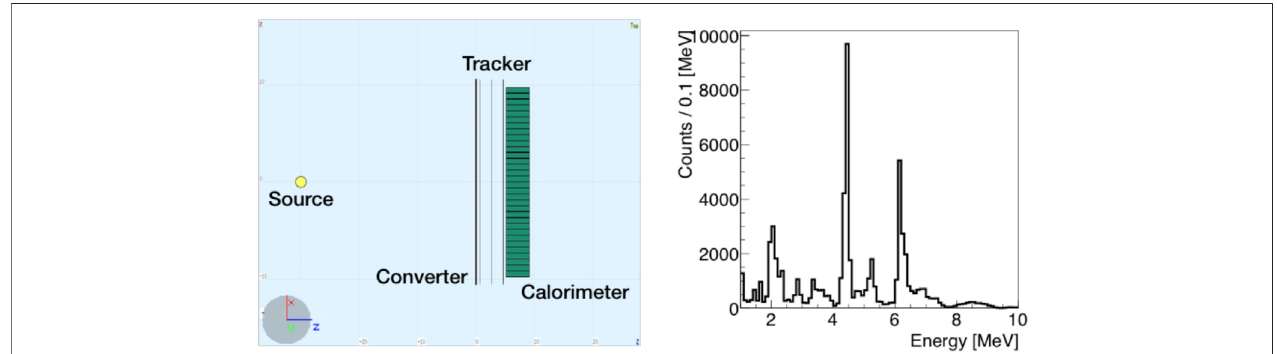
FIGURE2 |Left: visualization ofthe FLUKA simulated geometry (top view). Thephoton point source isrepresented bythe yellow dot. Right: PG energy spectrum at production obtained from the simulation of a 160 MeV proton beam impinging on a PMMA target.